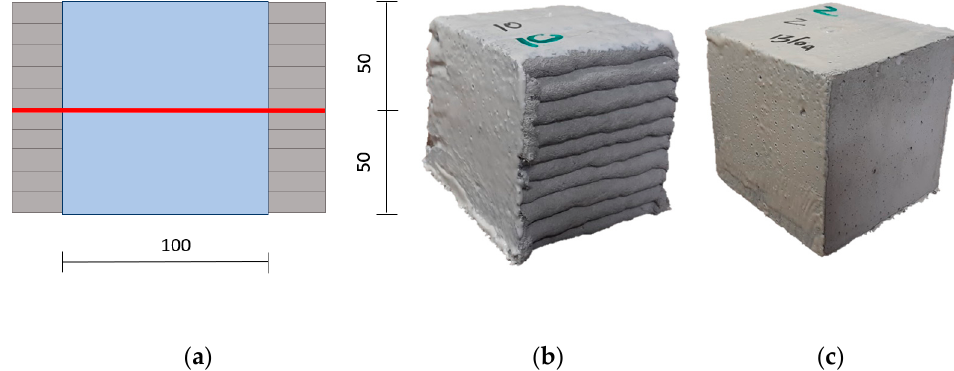
Figure 5. ( a ) Extraction of a 100 mm printed ACC specimen (CL indicated in red) producing ( b ) a printed cube, compared with ( c ) a reference cast specimen.